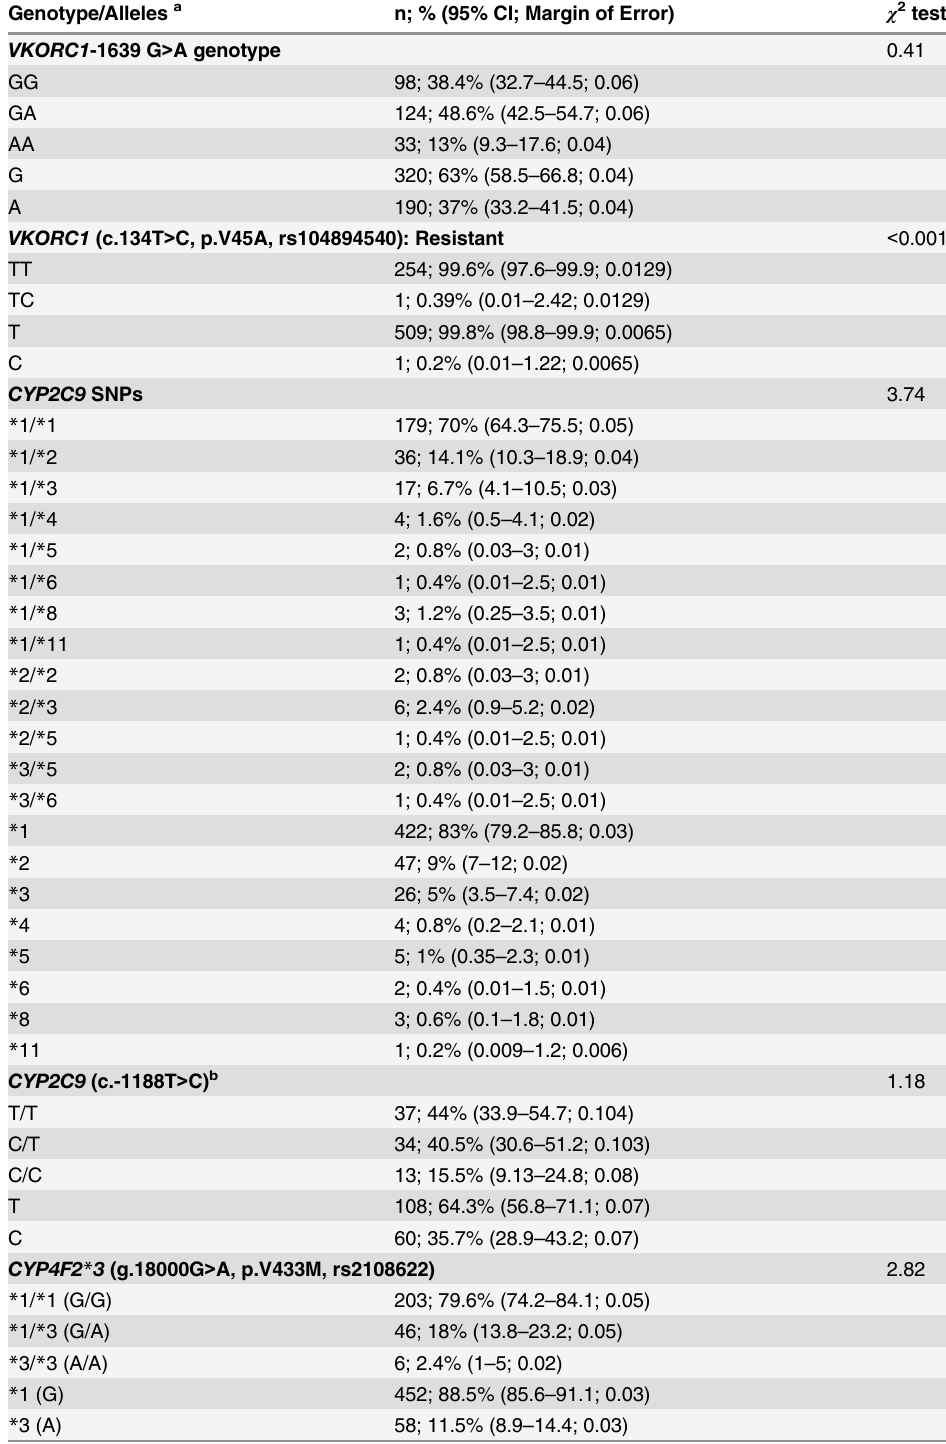
Table 2. Allele and genotype frequency distributions of CYP2C9 , CYP4F2 , NQO1 and VKORC1 poly- morphisms in Hispanic patients treated with warfarin at the VACHS-San Juan, PR (n = 255). Data expressed as percent (Wald-adjusted 95% Confidence Interval, CI). χ 2 < 3.84 meet HWE for genotypes, one degree of freedom, p <